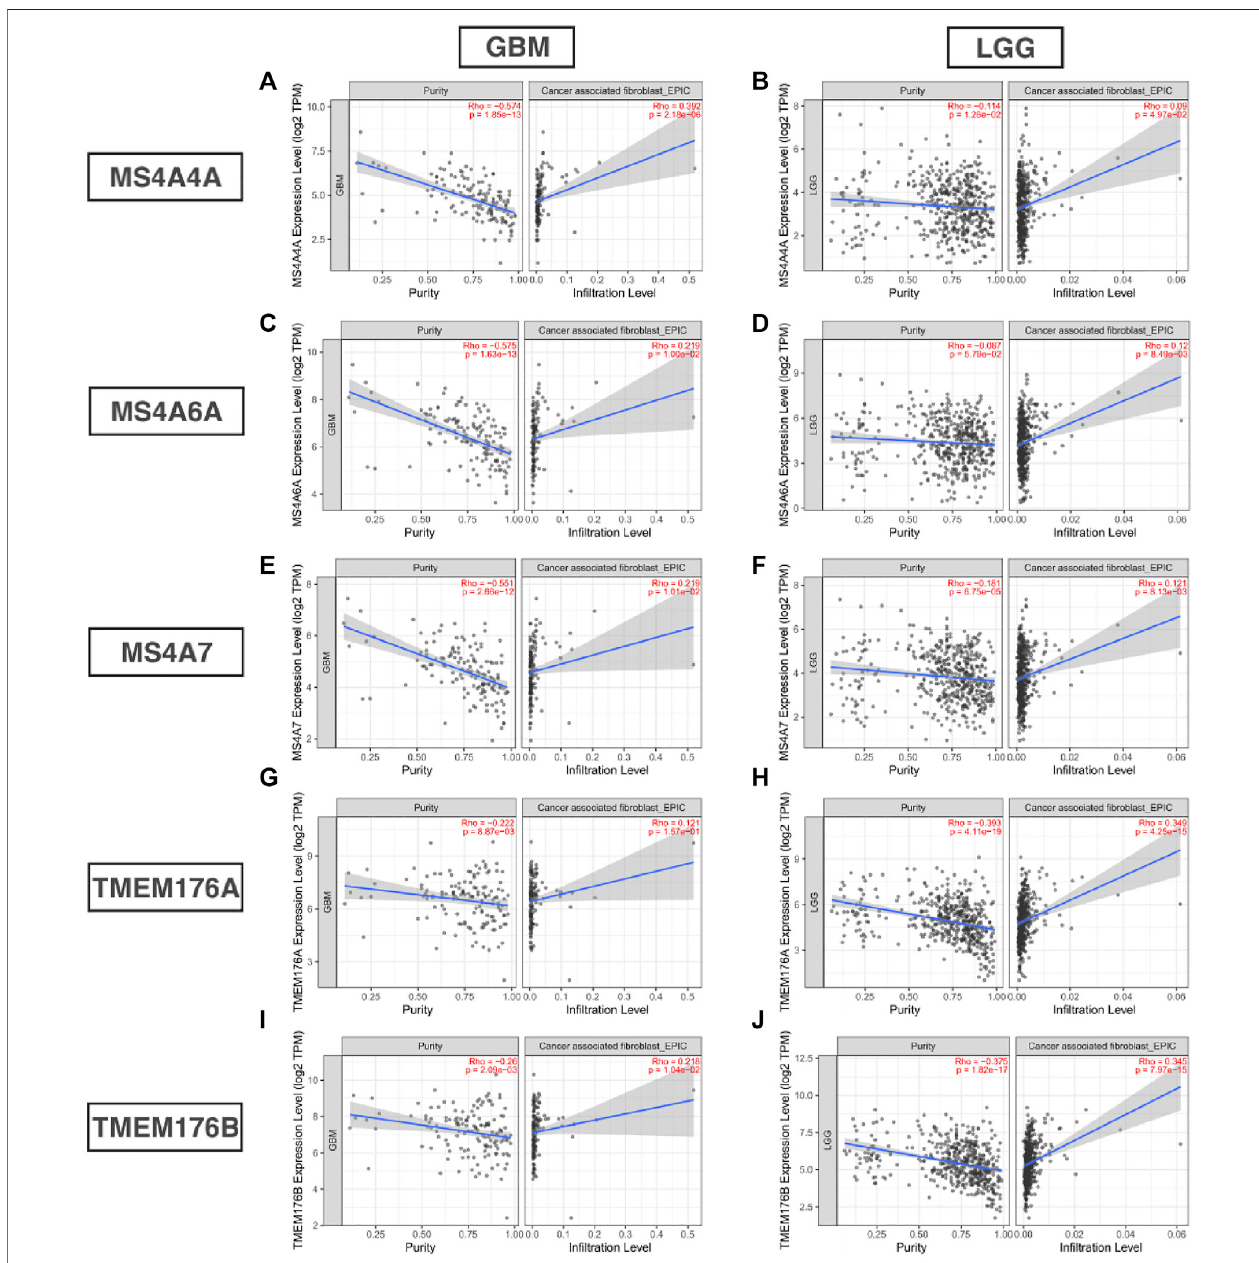
FIGURE 9 | Correlation between MS4As and the level of CAF in fi ltration in GBM and LGG (A – J) .